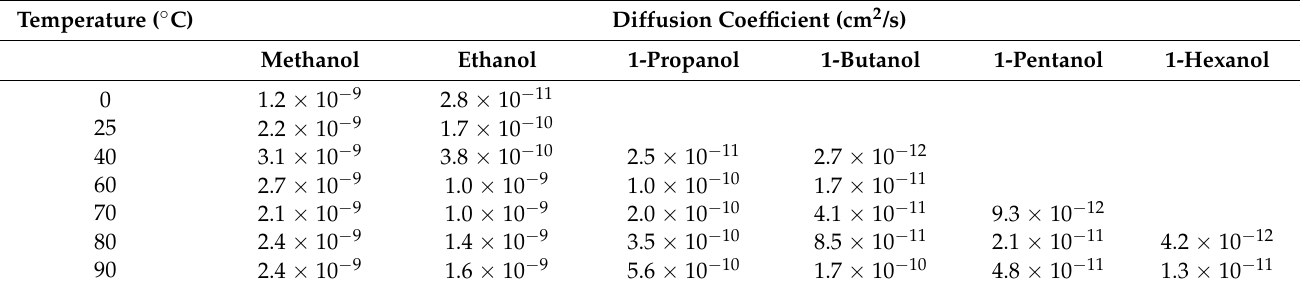
Figure 2. Experimental permeation curves for 1-butanol at 60 ◦ C, 70 ◦ C, 80 ◦ C and 90 ◦ C (lag time at 70 ◦ C: intercept of the red line on the time-axis). Table 5. Experimentally determined diffusion coefficients D P in GPPS of 1-alcohols from permeation